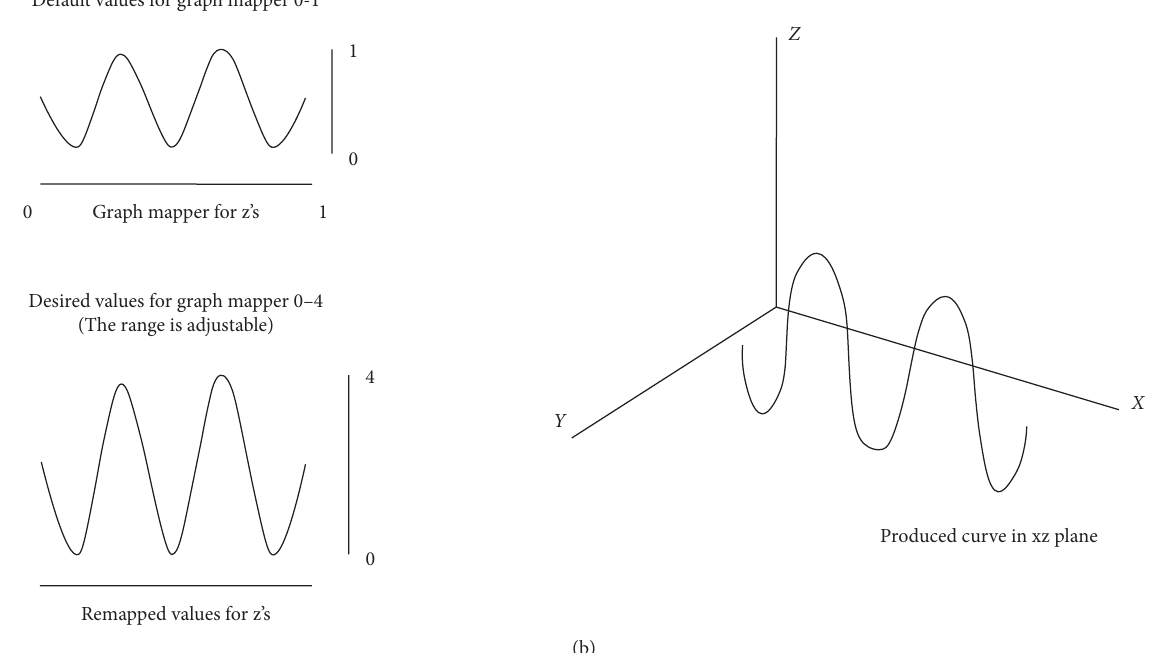
Figure 10: Logic static system of the model, inspired by the free movement angles (source: drawing by the research team).